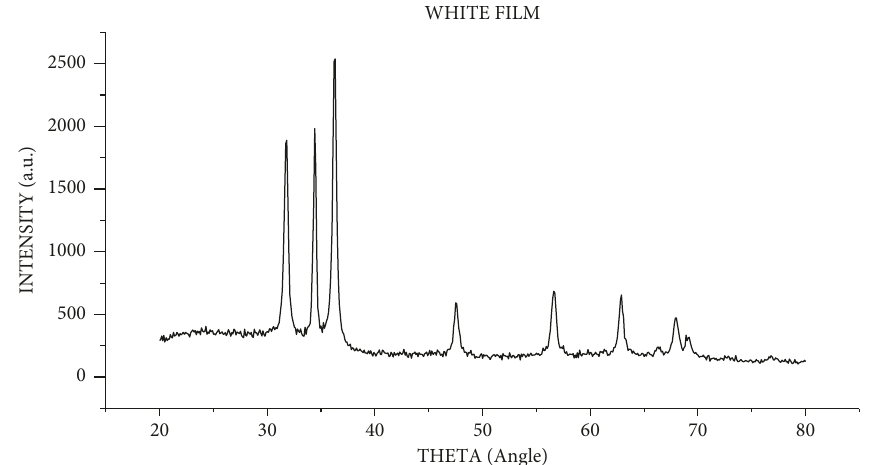
Figure 3: XRD image showing typical peak for zinc